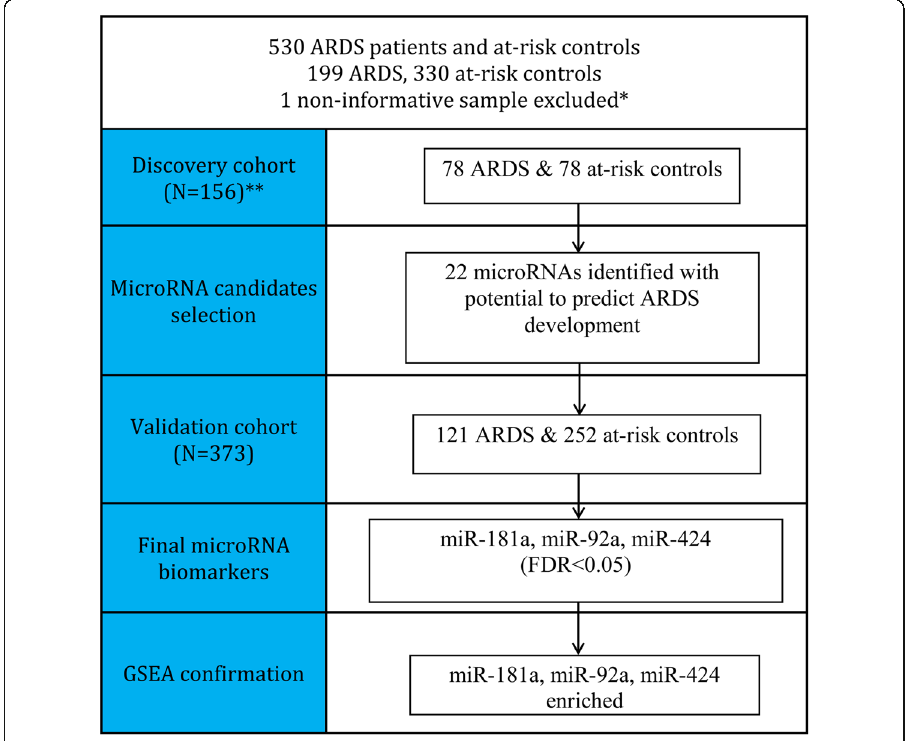
Fig. 1 Study design of discovery cohort, validation cohort, and gene set enrichment analysis (GSEA). *One control sample was excluded due to few detectable miRNAs. **Discovery cohort ARDS and at-risk controls were matched by age (± 5 years) and